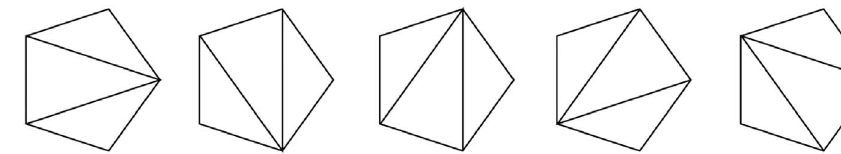
Figure 25. Five ways of cutting a pentagon, with diagonal knives.